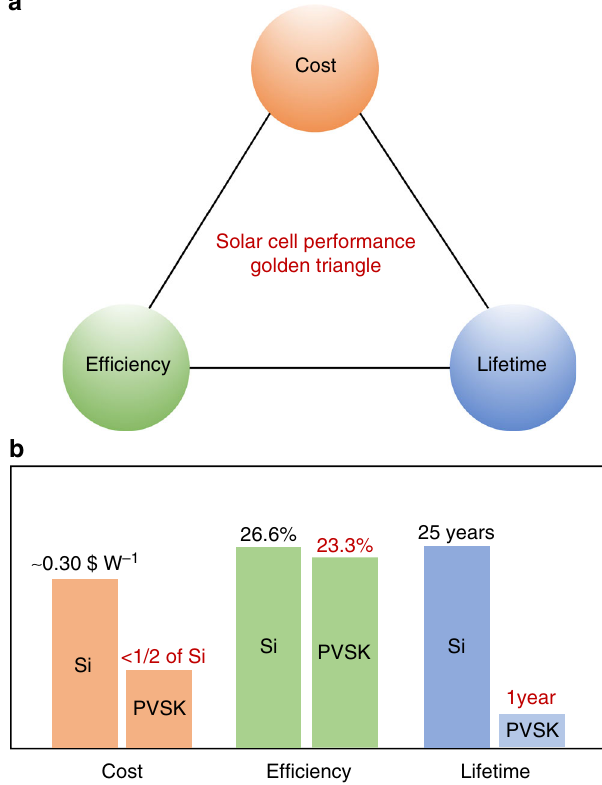
Fig. 1 The comparison of perovskite and silicon solar cells. a Golden triangle of solar cells, cost, ef fi ciency, and lifetime are considerd. b The comparison of perovskite and silicon solar cells based on golden triangle. Silicon solar cells have the champion ef fi ciency of 26.6% (21% for the module) lifetime of more than 25 years and cost of around 0.3 $ W − 1 . In comparison, the perovskite solar cells achieve the champion ef fi ciency of 23.3% (17% for the small module), the manufacture cost is around half of the silicon solar cells and the lifetime of only one year at